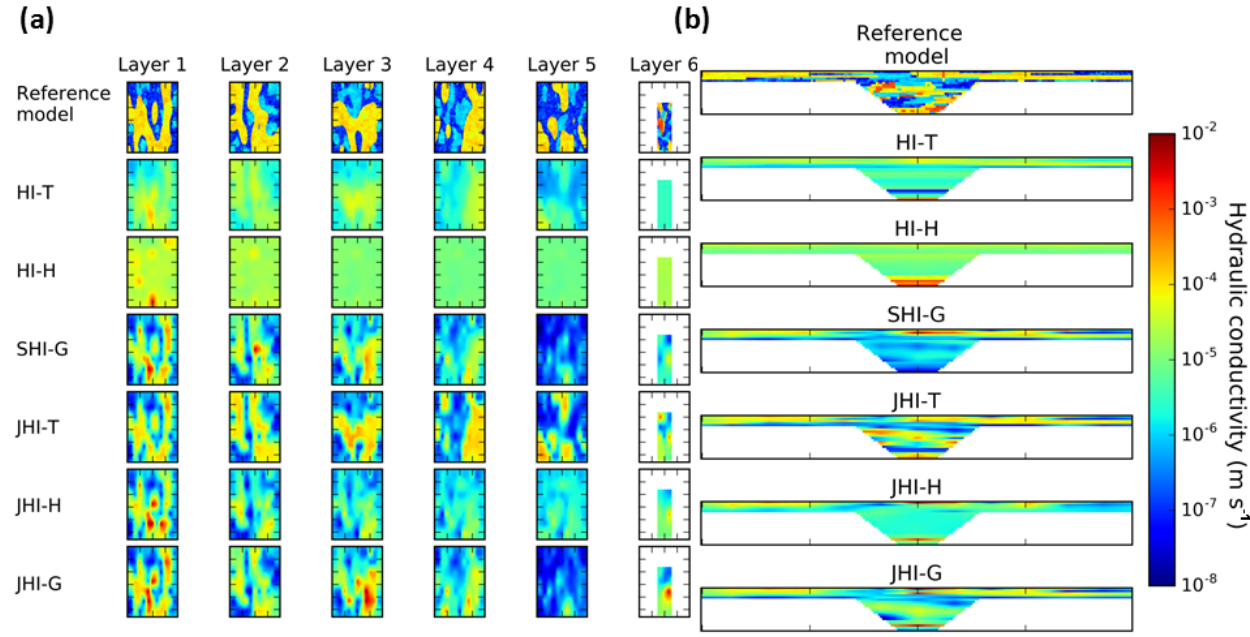
Figure 5. Reference and estimated hydraulic conductivity fields for model realization number 189: (a) shows the fields for layers 1 to 6; (b) shows the field along an east–west cross section in the middle of the domain.